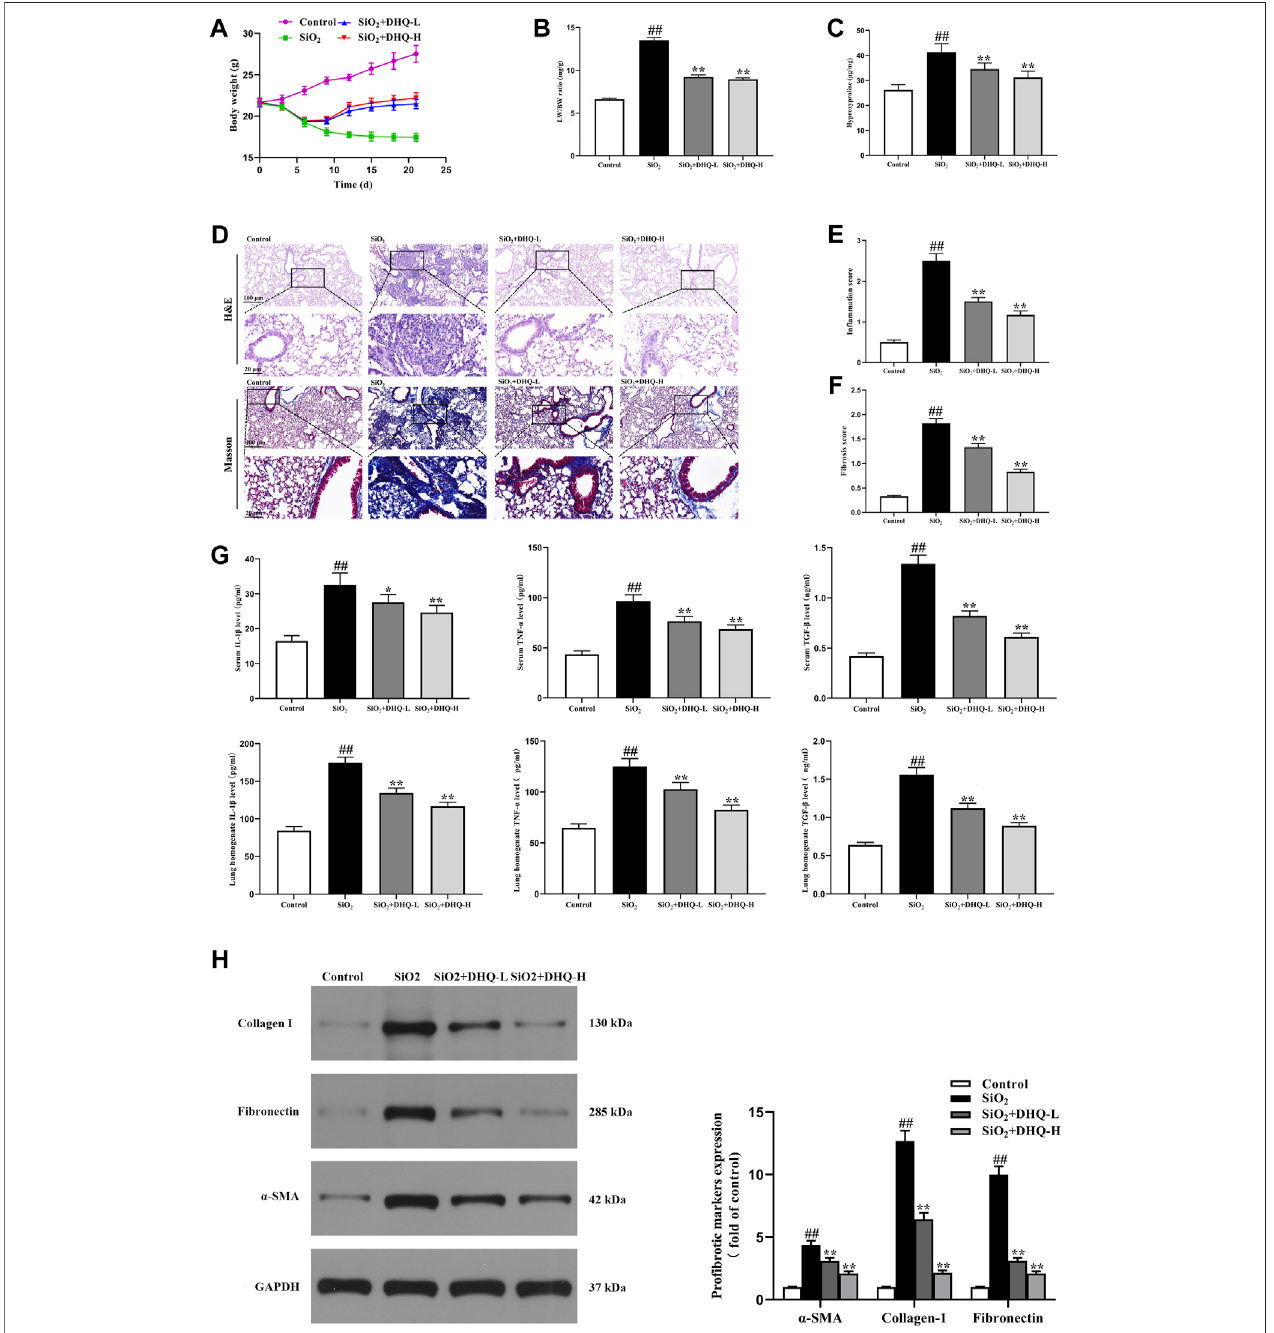
FIGURE 1 | DHQ attenuated SiO 2 -induced pulmonary fi brosis in C57/BL6 mice One week after 0.2 g/kg SiO 2 treatment, mice were orally administered with two dosesofDHQ-L(10 mg/kg)and DHQ-H (50 mg/kg) onceadayfor14 days. (A) Thechangesofbodyweight. (B) ThechangesofLW/BWratio. (C) TheHYPcontentsin lung tissues were determined. (D) Representative images ( × 200) of HE-stained and Masson-stained sections of mouse lung were shown. Bar = 100 μ M. (E) , (F) The in fl ammation and fi brosisscorenumbers of0 – 3,representing the gradesof – ,+, ++,and +++,weredeterminedbyexperiencedpathologistsblindly. (G) Thelevels of pro-in fl ammatory cytokines in serum and lung homogenate were measured by ELISA. (H) The protein levels of α -SMA, collagen I and fi bronectin in lung tissues were measured by western blotting. Data are shown as mean ± SD, All experiments were repeated three times. # p < 0.05, ## p < 0.01 vs. the control group; * p < 0.05, ** p < 0.01 vs. the SiO 2